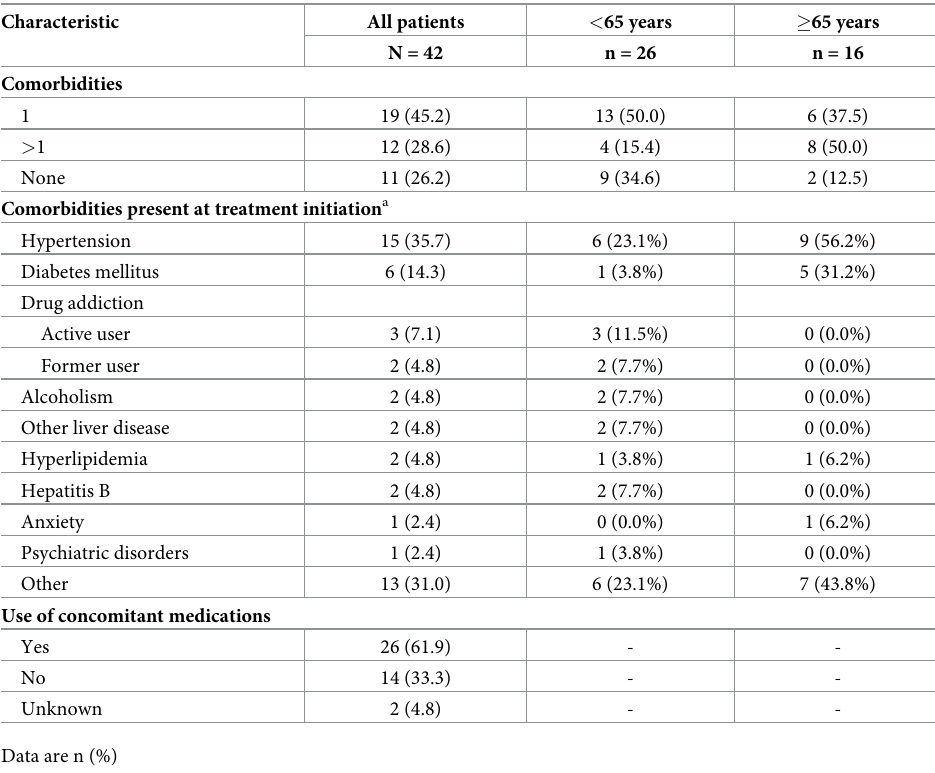
Table 2. Comorbidities and use of concomitant medications.